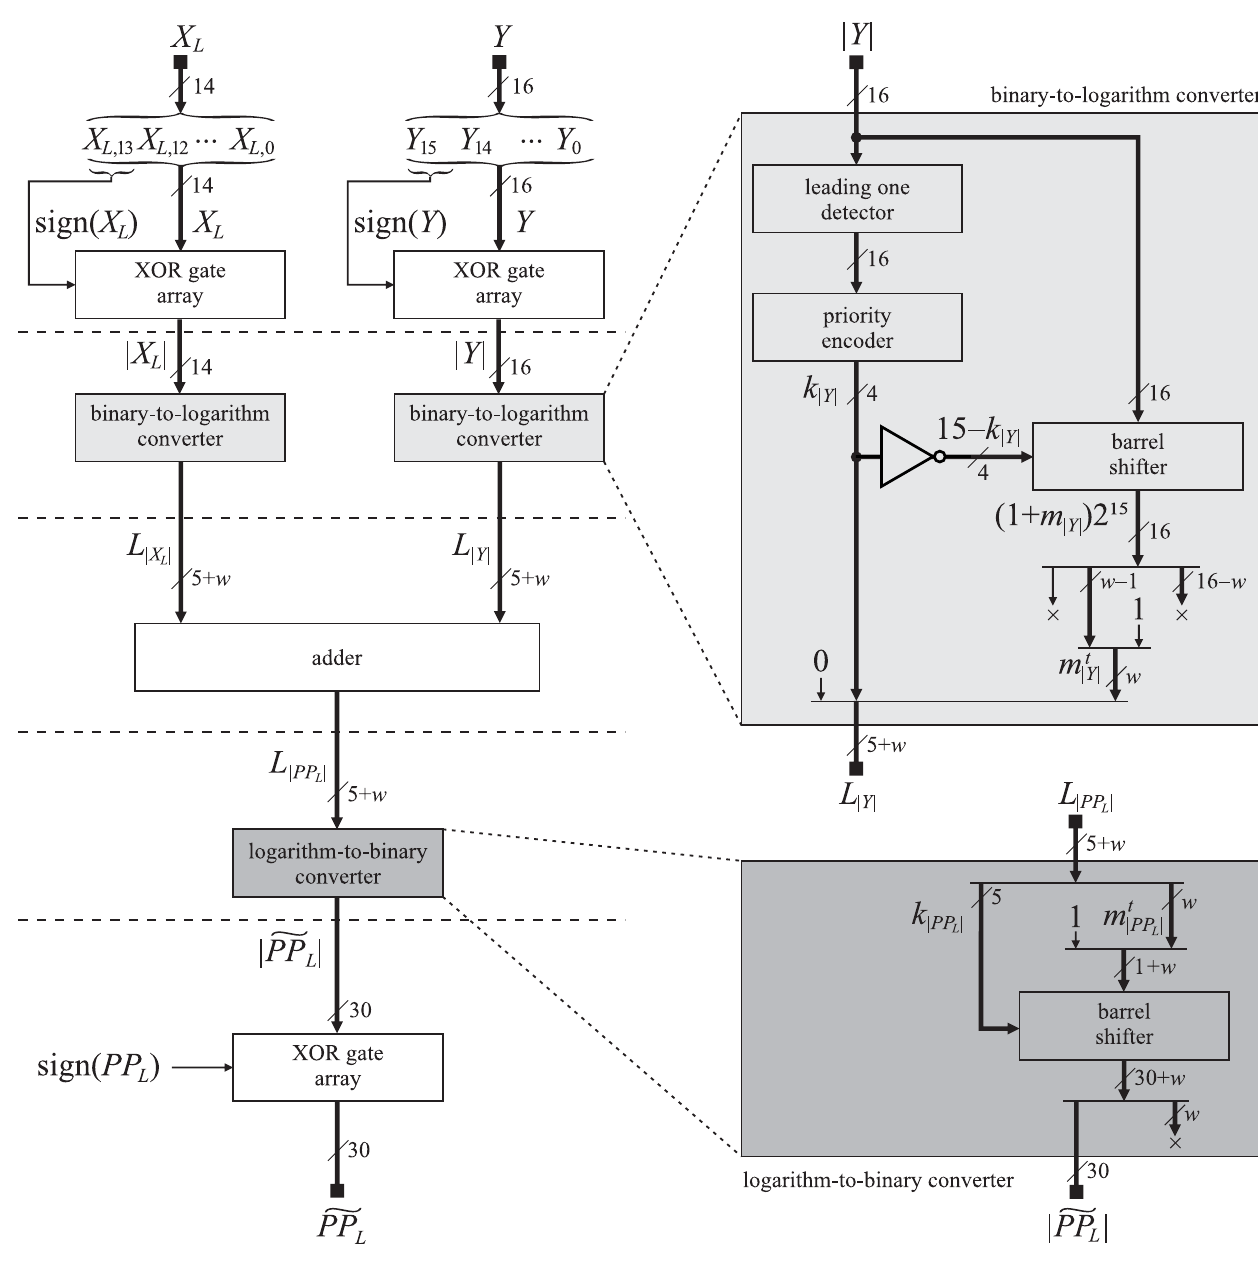
Figure 3. Block diagram of the approximate logarithmic